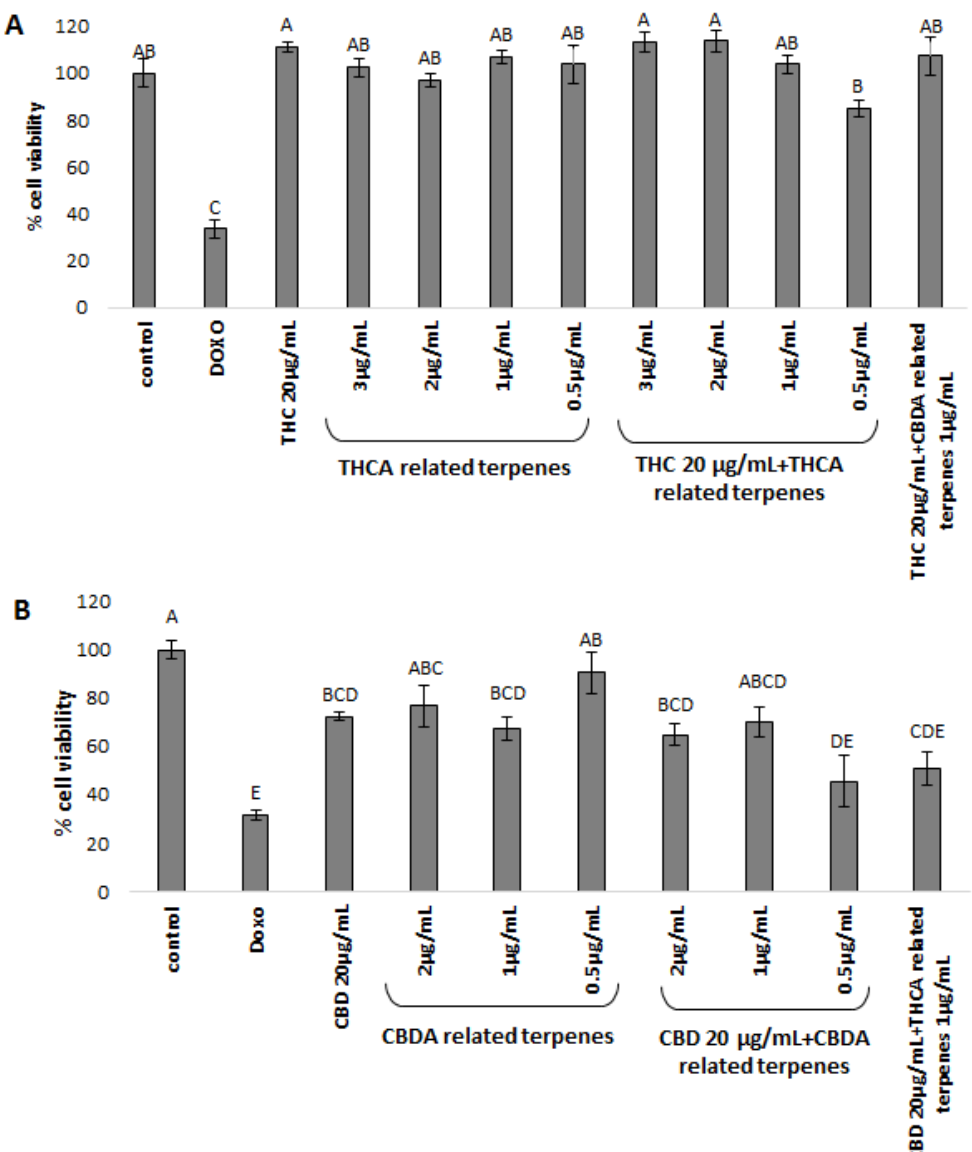
Figure 3. XTT cell viability assay of the HCT-116 cell line, treated for 48 h with ( A ) THC; and ( B ) CBD. THC / CBD—in all treatments the phytocannabinoid concentration was 20 µ g / mL. The various concentrations of co-related terpenes and cross-related terpenes are detailed in the figure. Control—mixture of methanol and hexane (1:1), the solvent used for extraction and treatment. Doxo—doxorubicin 1 µ g / µ L. THCA-related terpenes—terpenes listed in Table 1A for Cs12 strain, fraction 6. CBDA-related terpenes—terpenes listed in Table 1B for the Arbel strain, fraction 3. THC + CBDA-related terpenes and CBD + THCA-related terpenes treatments were carried out at a ratio of 1:20 (1 µ g / mL:20 µ g / mL terpenoid:phytocannabinoid). Total amounts were extrapolated from the dry weight of the extract and the relative amounts of the di ff erent molecules identified, as calculated from the area under the peak, valued by GC-personalized integration parameters. Percent cell viability is presented as mean ± SD (uppercase letters mark statistical significance) of all treatments in replicas. Values with di ff erent letters are significantly di ff erent from all combinations of pairs, according to the Tukey–Kramer honest significant di ff erence (HSD, P ≤ 0.05).